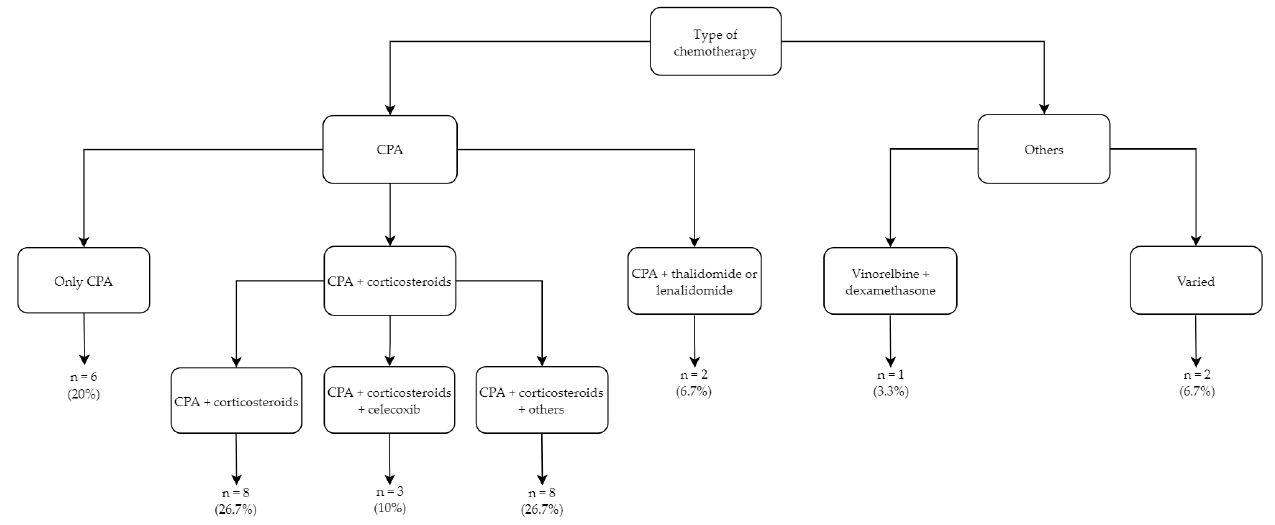
Figure 4. Details of the LDMC regimens. CPA = cyclophosphamide.